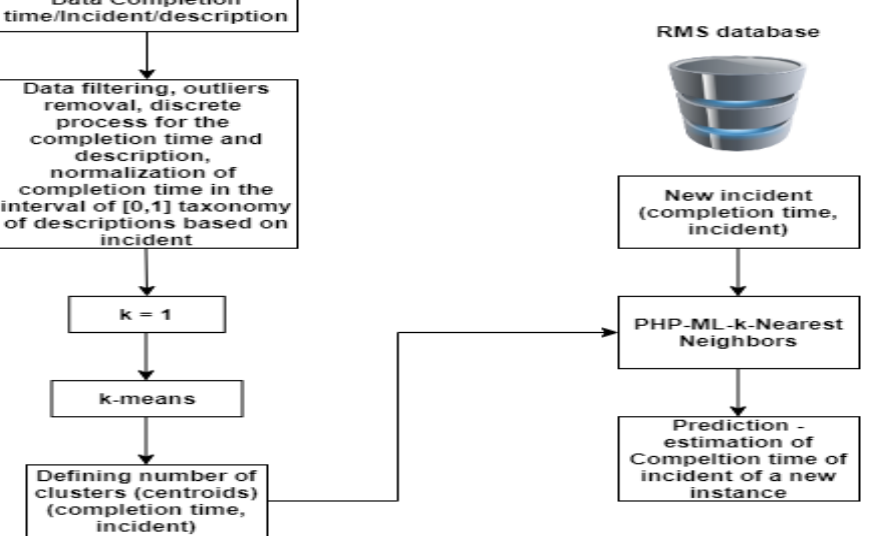
Figure 7. Illustration of the completion time steps. Estimation of Completion Time of motorway’s field personnel when an incident